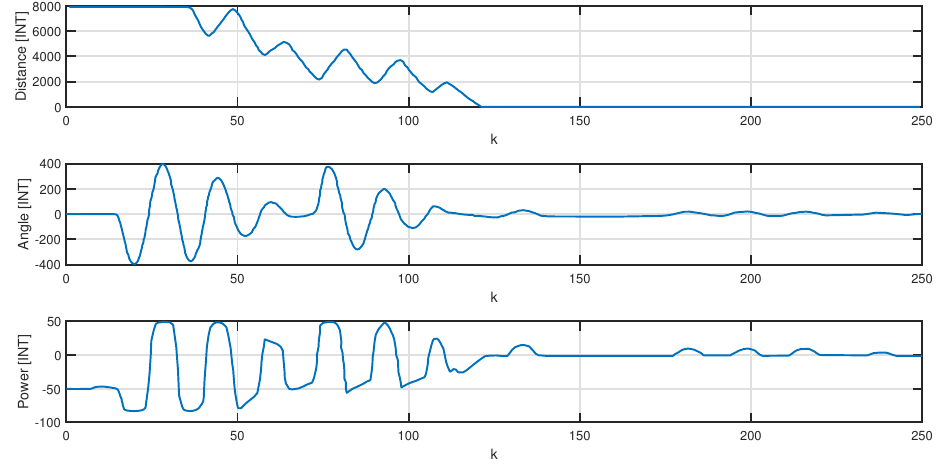
Figure 10. Fuzzy control with disturbance during the whole